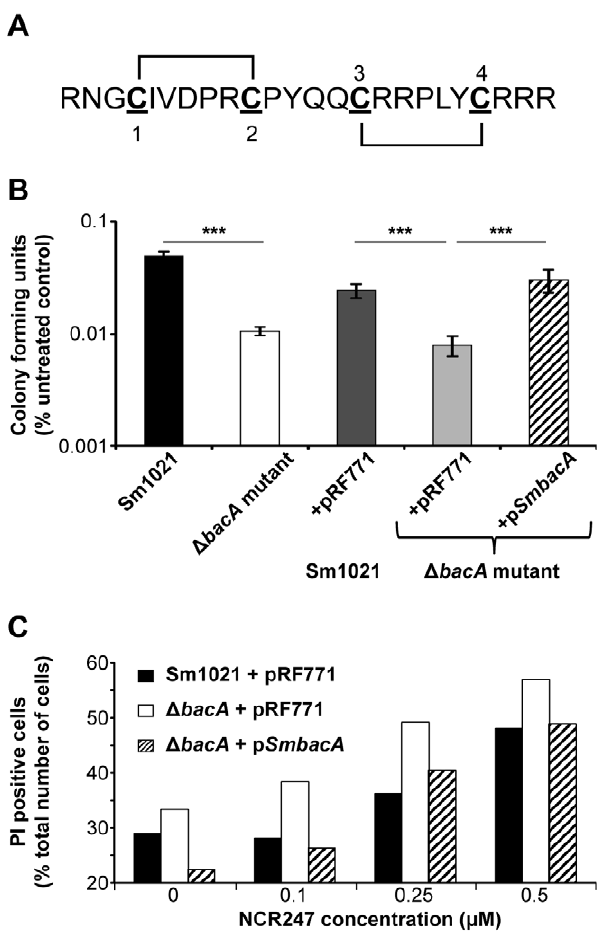
Figure 1. BacA proteins protect S.meliloti in vitro against the antimicrobial activity of NCR247. (A) NCR247 peptide sequence showing the two S-S bridges between cysteine residues 1 and 2 and 3 and 4. (B) Colony forming ability of the indicated strains was assessed after exposure towards 20 m M of the NCR247 peptide for 3 h. (C) The PI fluorescence of cells was determined by flow cytometry after treatment of cultures with and without the NCR247 peptide for 3 h. Bars represent mean 6 SD. The significance value *** p # 0.001 was determined using ANOVA followed by a Student Newman-Keuls post-test and results are representative for at least two independent